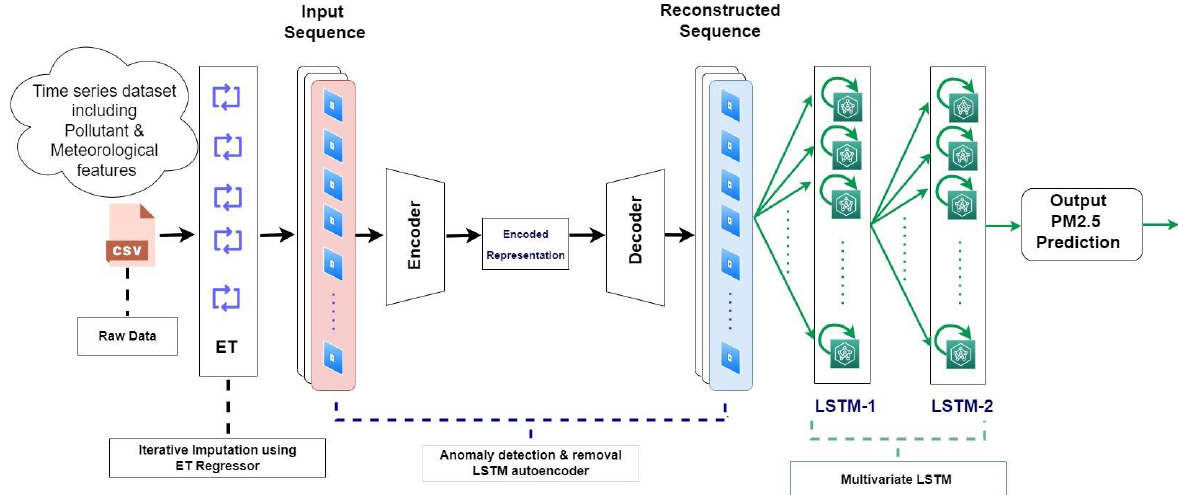
Figure 1. MIA-LSTM model.